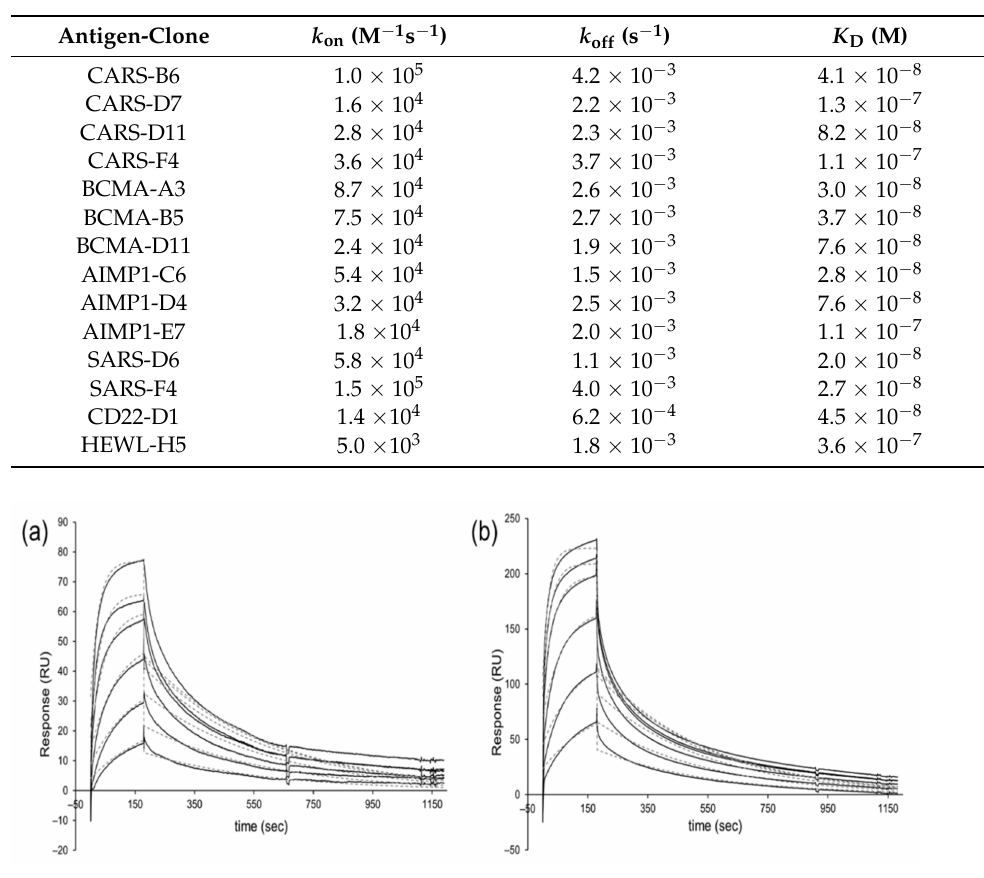
Table 3. Binding kinetics parameters of target-binding scFvs selected from OPAL-T.